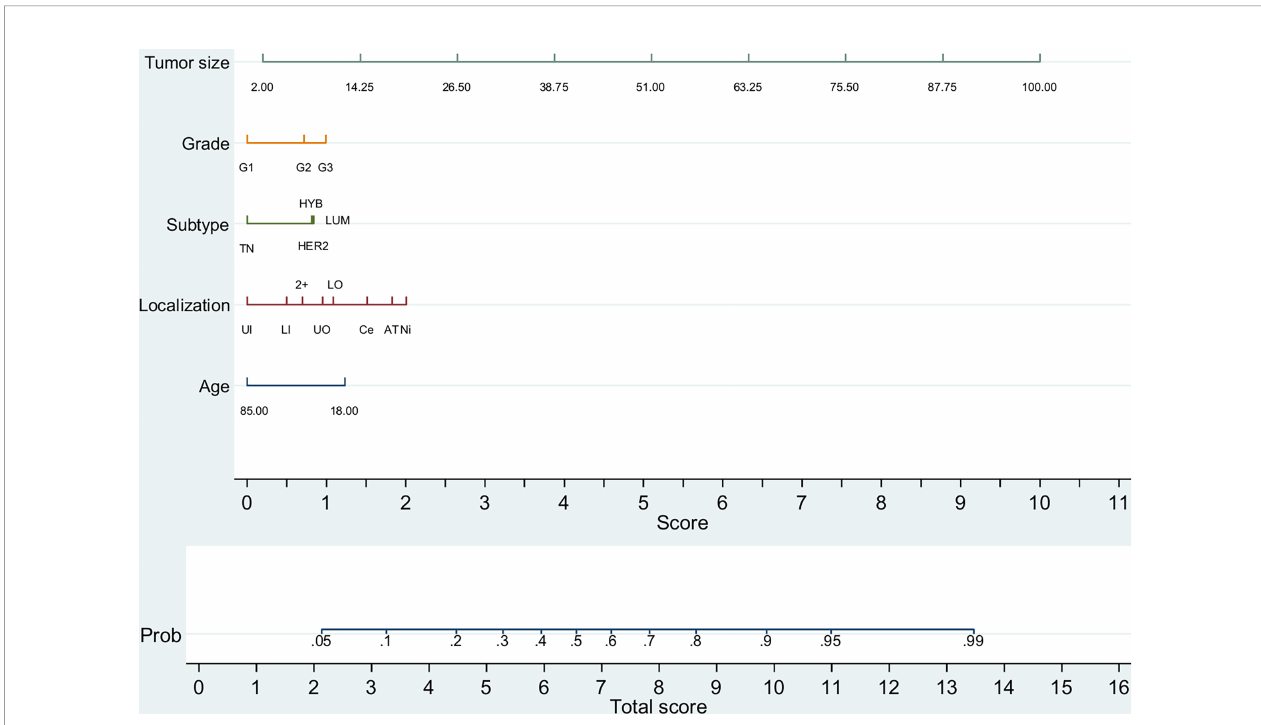
FIGURE 1 | Predictive nomogram for any metastatic lymph node (pN+) ( n = 90,142). TN, triple-negative (HR − /HER2 − ); LUM, luminal (HR + /HER2 − ); HYB, luminal hybrid (HR + /HER2 + ); HER2, HER2 enriched ((HR − /HER2 +) ); UI, upper inner quadrant; LI, lower inner quadrant; 2+, overlapping quadrants; UO, upper outer quadrant; LO, lower outer quadrant; Ce, central quadrant; Ni, nipple; AT, axillary tail. Tumor size is depicted in